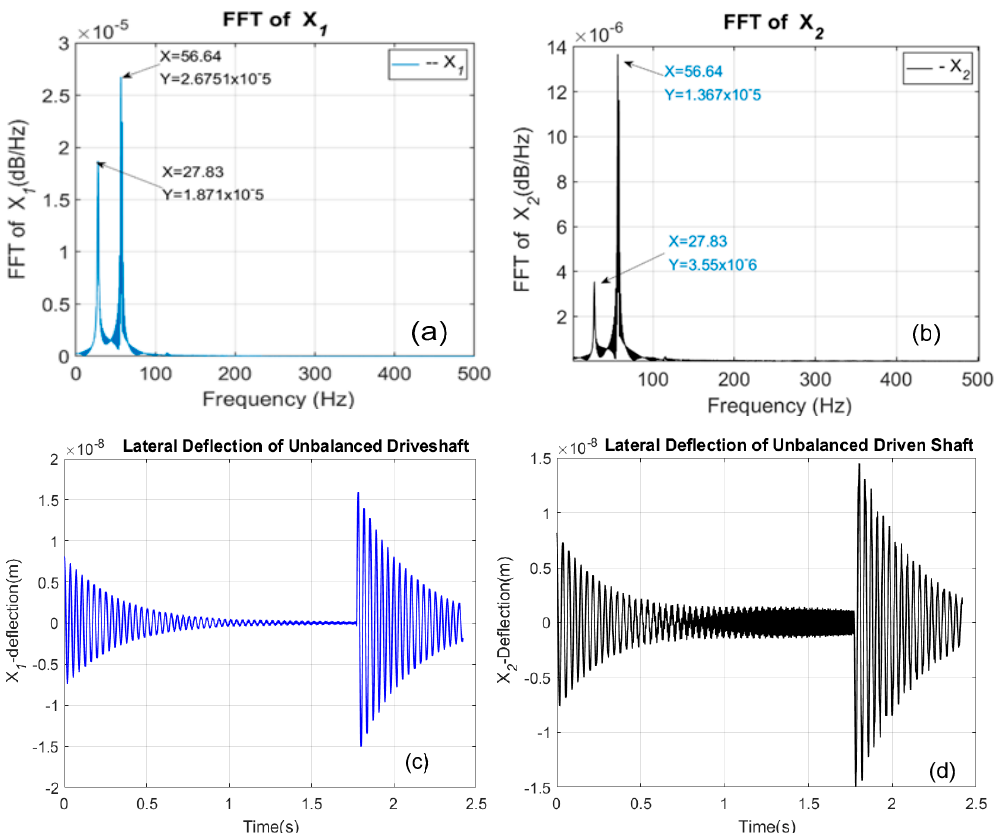
Figure 6. Simulation results of the coupled rotor system without a crack: ( a ) shaft speed profile, ( b ) frequency spectrum, and ( c , d ) horizontal deflection of drive and driven shafts.